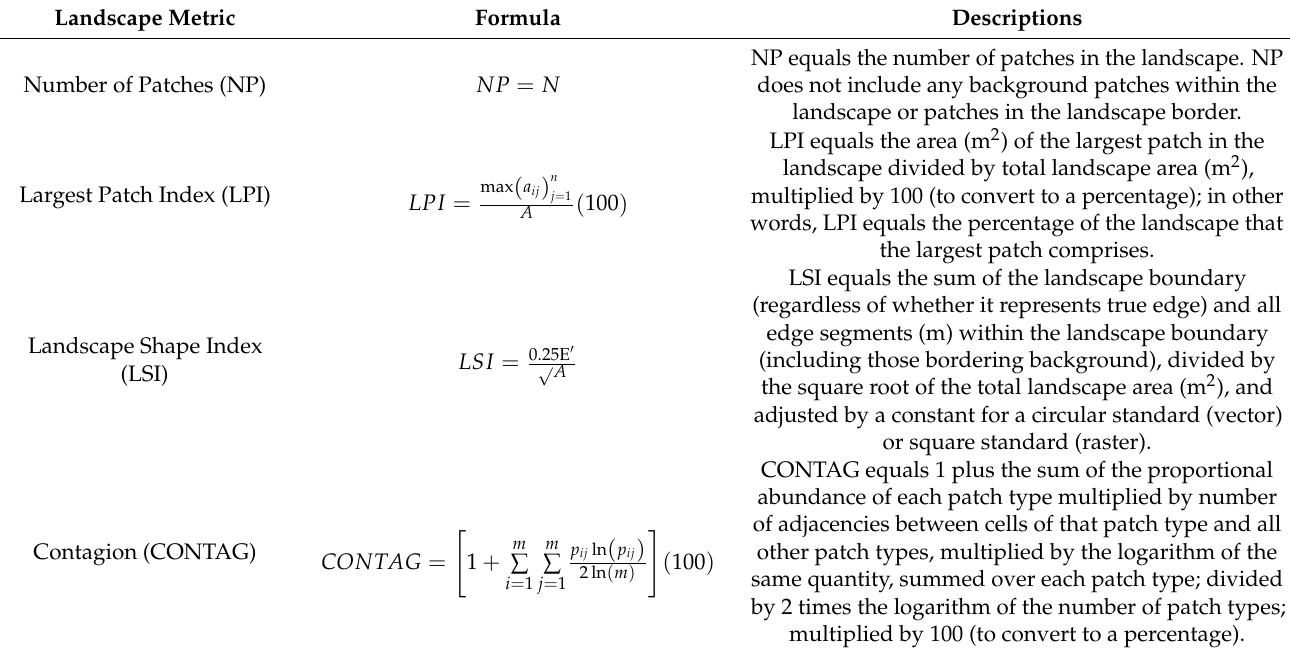
Table 5. Landscape Metrics and descriptions adopted from